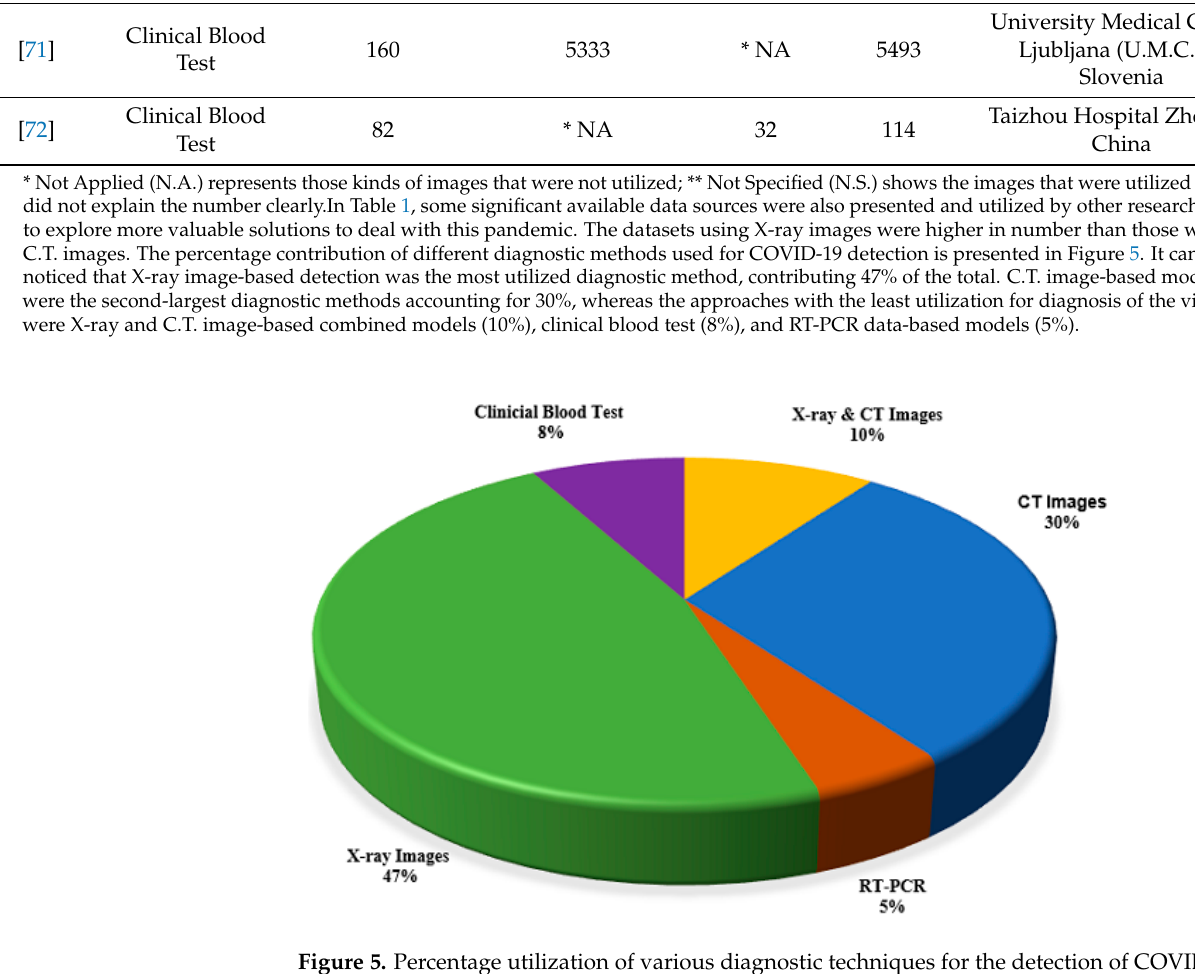
Figure 5. Percentage utilization of various diagnostic techniques for the detection of